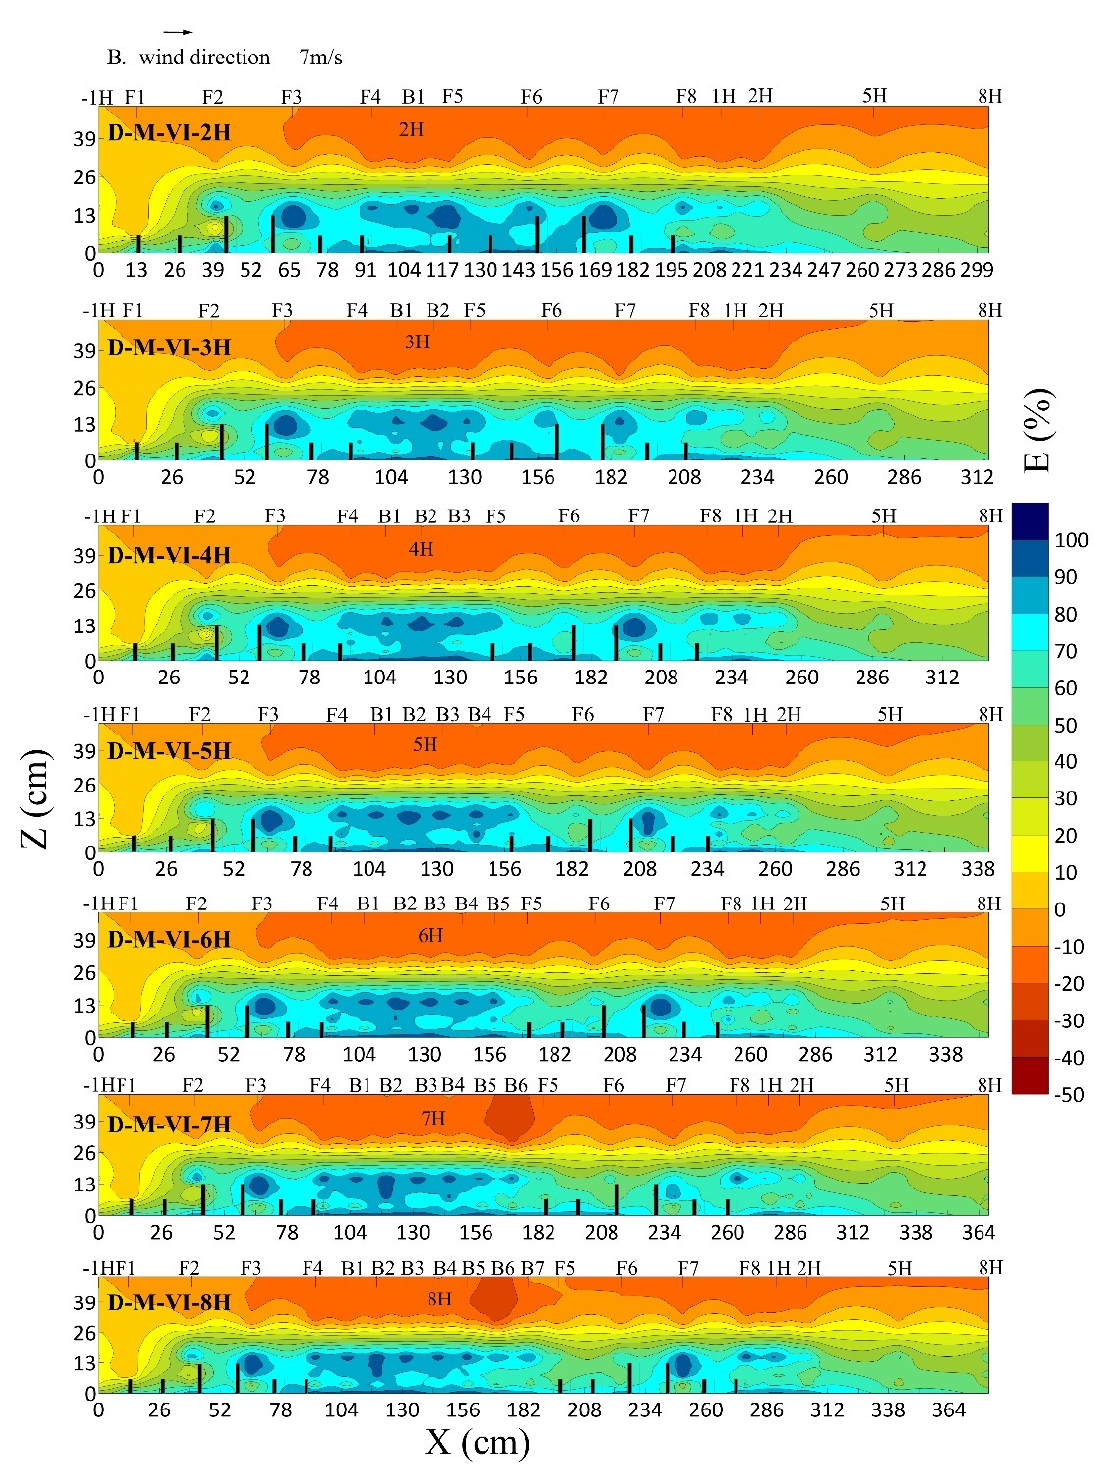
Figure 9. Contour map of the distribution of the shelter efficiency of double mixed shelterbelts of arbors and shrubs under different belt spacings. The belt spacing ranges from 2H to 8H. The abscissa represents the downwind distance (cm) and the ordinate represents the vertical height (cm). The top abscissa represents the observation point. The legend indicates the shelter efficiency.